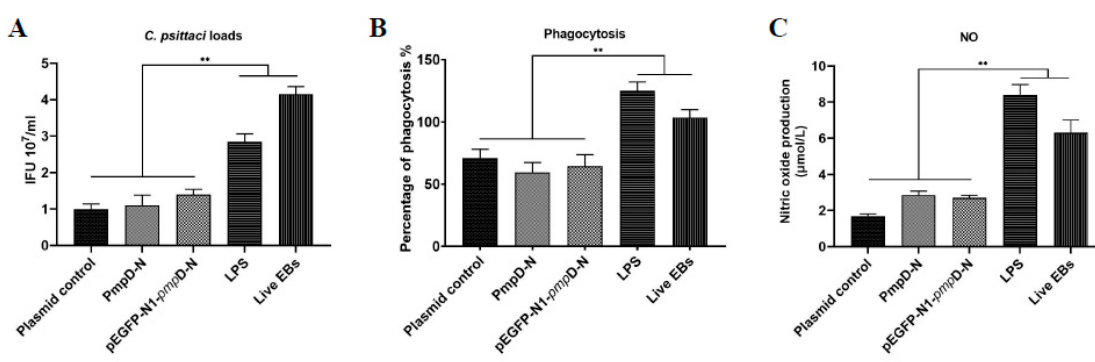
Figure 2. The e ff ect of PmpD-N on chlamydial load, phagocytic function, and nitric oxide (NO) production in the HD11 cells after treatment with PmpD-N or pEGFP-N1- pmp D-N. ( A ) The data showed the mean number of chlamydial inclusion forming units (IFU) for each group. ( B ) Phagocytic activity was calculated as the ratio between the MFI of each group and the net phagocytic value. The data showed the percentage of phagocytic activity ( ± SD) for cultures for each experiment. ( C ) The concentration of NO was measured by the Griess method and di ff erences were compared at ** p < 0.01. 2.4. The E ff ect of PmpD-N on the Release of Nitric Oxide in HD11